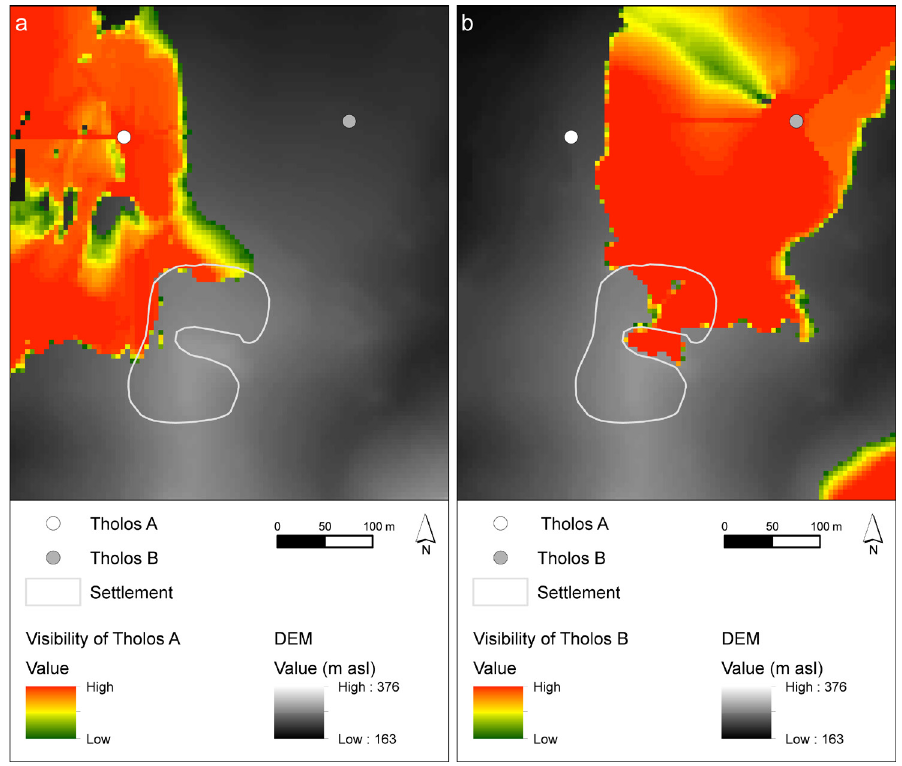
Figure 8. Cumulative viewshed of Tholos A (a) and Tholos B (b) at Apesokari. Areas of high visibility (in red) are those from where the entire tomb was visible, whereas areas of low visibility (in green) were intervisible only with the top of the tomb. The models assume an original height of 4.4 m for Tholos A and 5.1 m for Tholos B – based on a theoretical ratio of 0.9 between the inner diameter of the tombs and their estimated